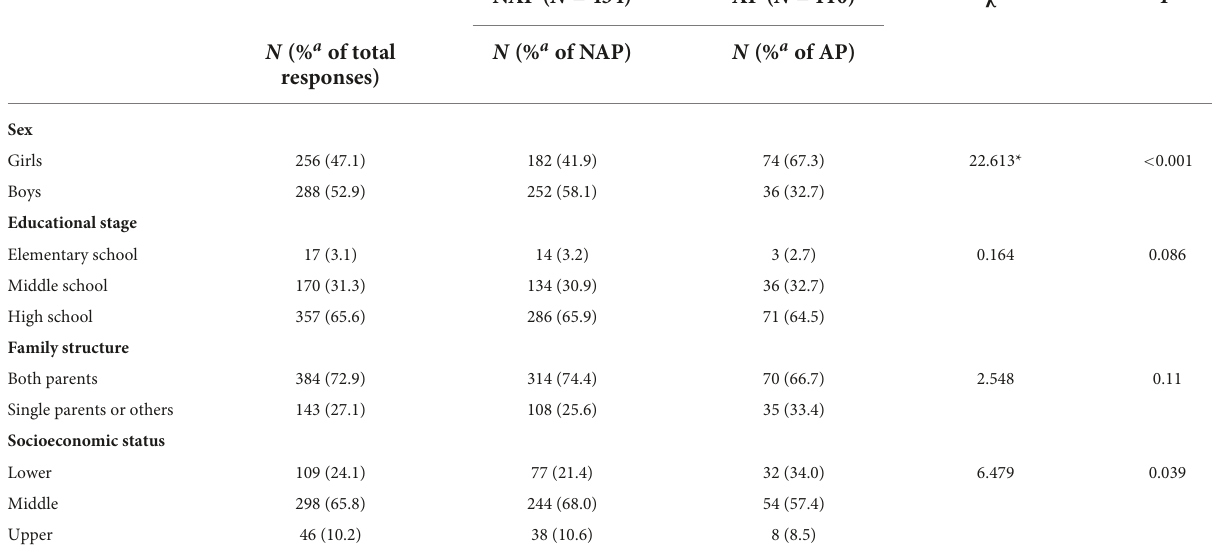
TABLE 1 Sociodemographic characteristics.